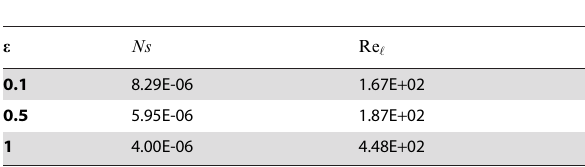
Table 5. EPF with different values of e .